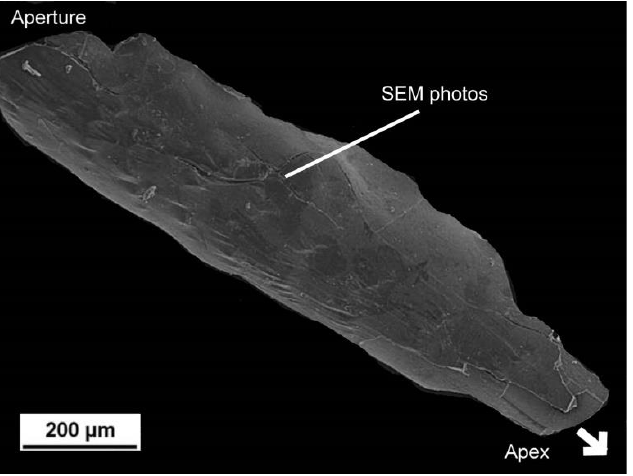
Figure 10. Periderm of Torellella from the upper Cambrian of Estonia. Location of SEM images in- dicated.